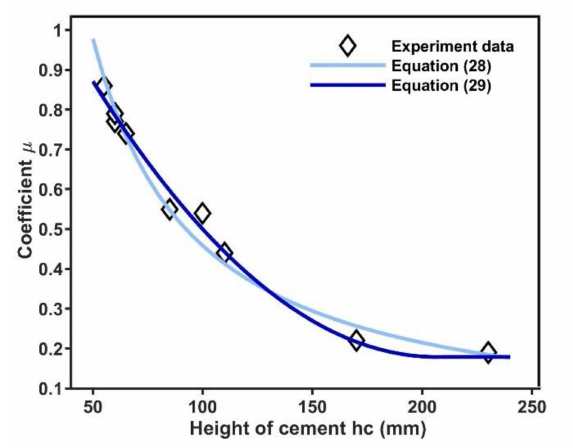
Figure 7. Fitted curve of the elasticity coefficient, µ